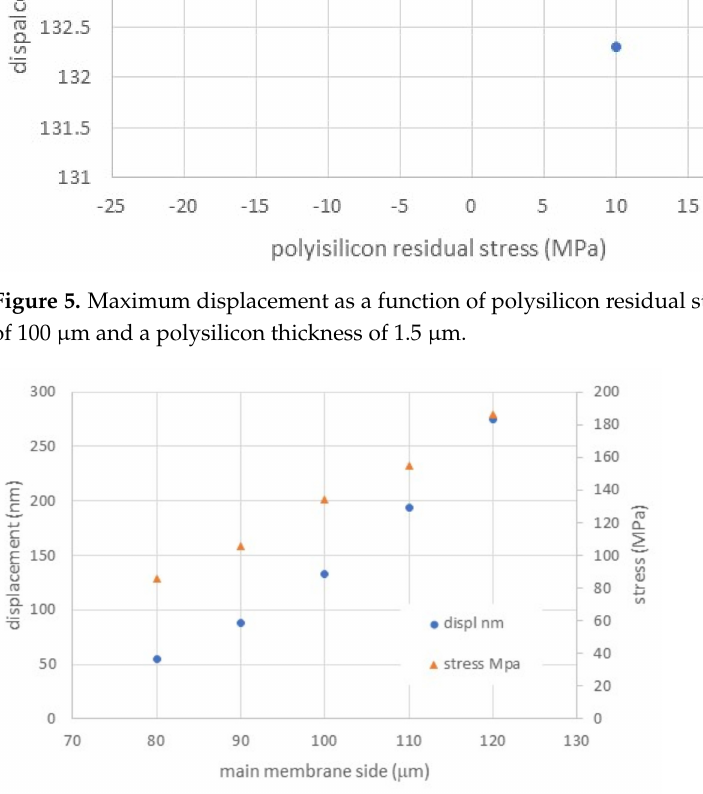
Figure 6. Maximum membrane displacement as a function of its side length, with polysilicon thickness of 1.5 µ